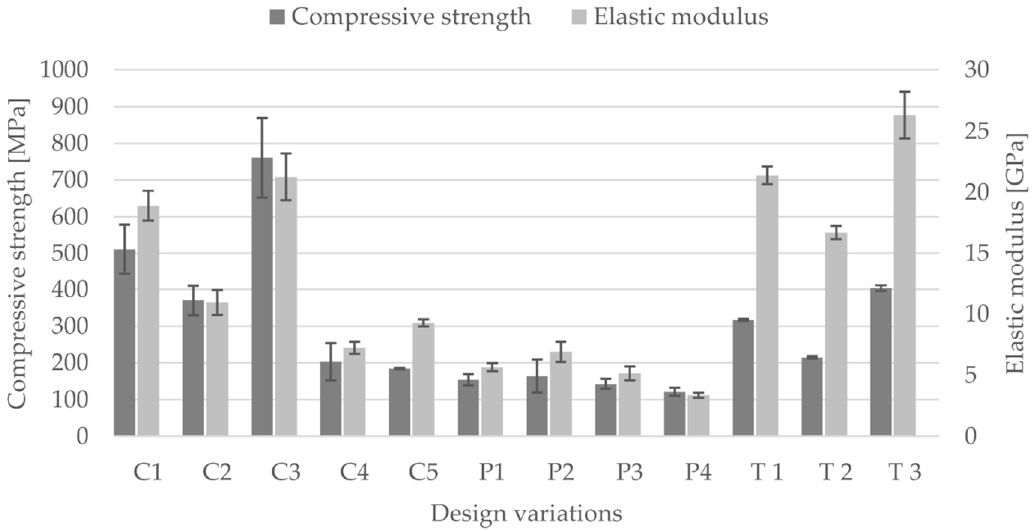
Figure 6. Elastic modulus and compressive strength for the three investigated designs (cube, pyramid and twisted) and the different configurations as calculated from axial compression testing. Results are shown as mean values with the corresponding standard deviation ( n = 5 for each design).